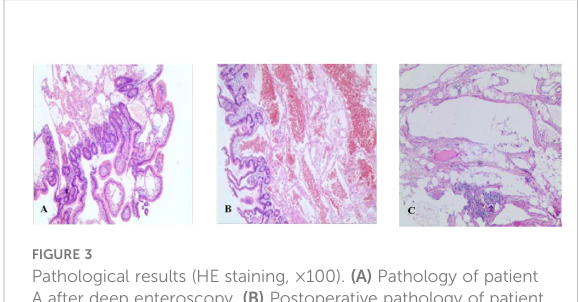
FIGURE 3 Pathological results (HE staining, ×100). (A) Pathology of patient A after deep enteroscopy. (B) Postoperative pathology of patient A. (C) Postoperative pathology of patient B.